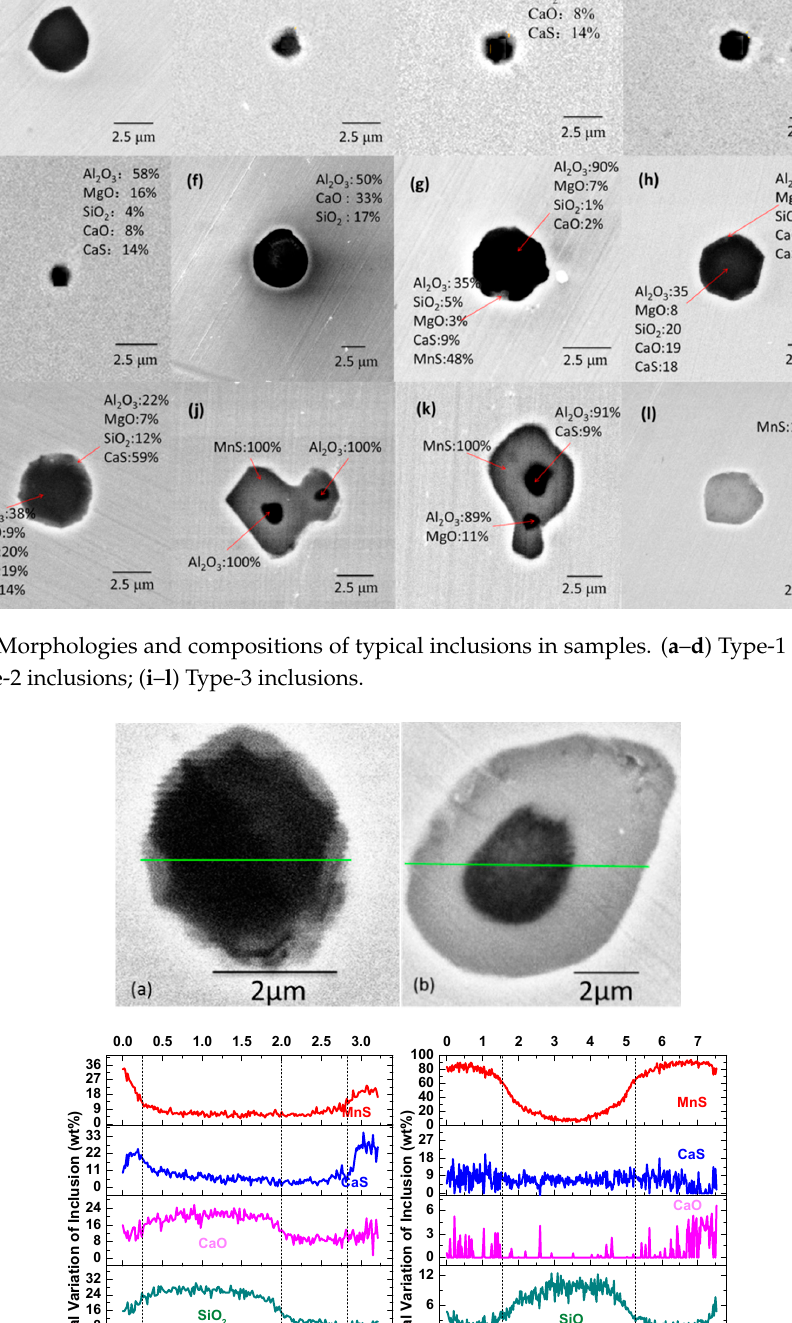
0.0 0.5 1.0 1.5 2.0 2.5 Figure 2. Line scanning of compositions for inclusions with multi-phased morphology. ( a ) SEM graph; ( b ) line scanning results.